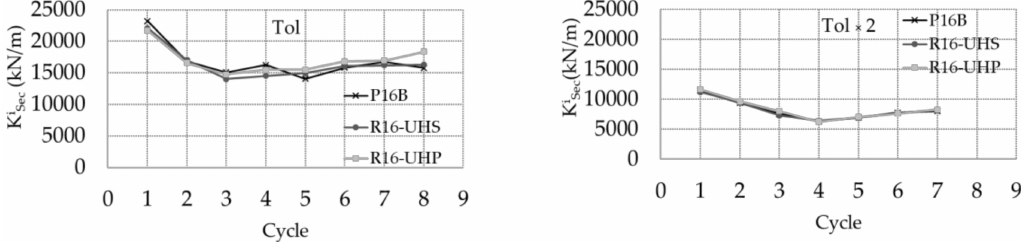
Figure 12. Experimental secant stiffness (k i sec ) measured at each cycle for the column P16B (the ASB column) and the RR columns R16-UHS and R16-UHP during the Tol and Tol × 2 parts of the displacement history.